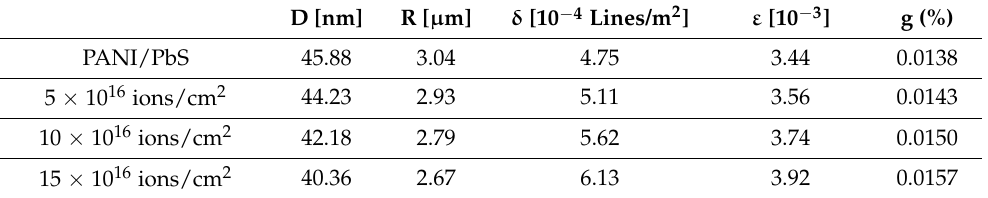
Table 1. The induced micro-structural parameters of the pure and irradiated